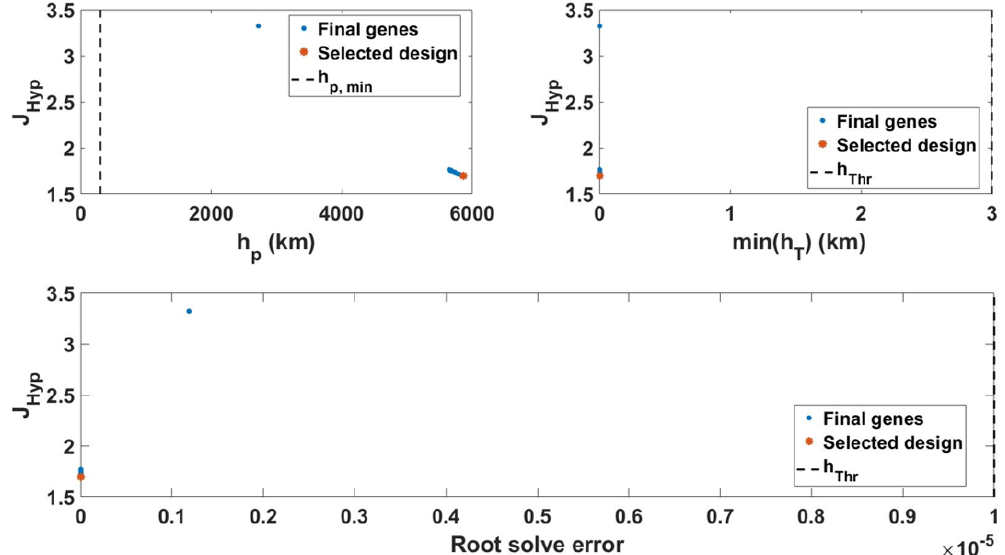
Figure 21. The figures of merit of the hyperbolic flyby design problem along with the selected optimal